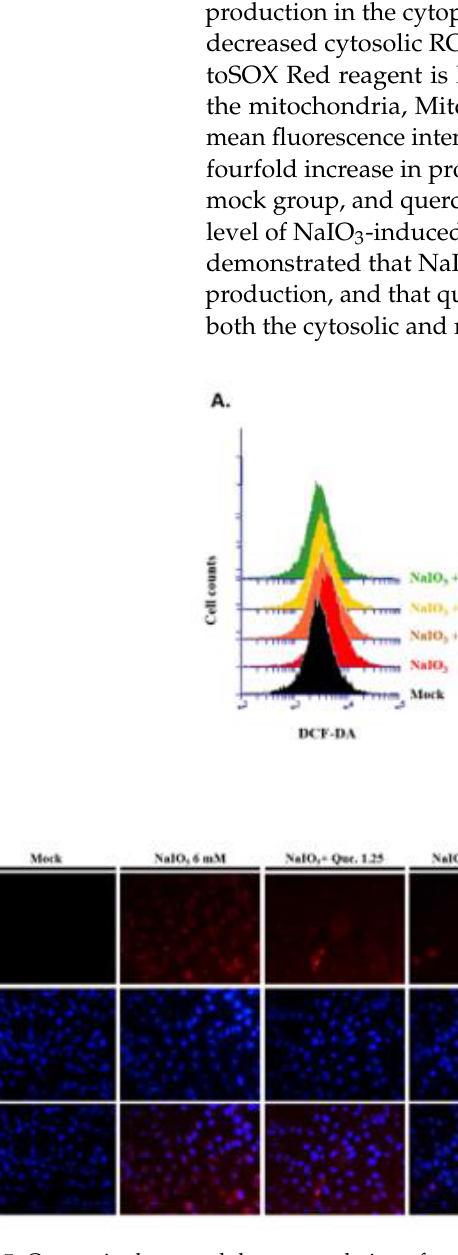
Figure 5. Quercetin decreased the accumulation of cytosolic and mitochondrial ROS in NaIO 3 -treated ARPE19 cells. ARPE- 19 cells were either untreated (mock) or treated with 0, 1.25, 2.5, or 5 μM quercetin followed by NaIO 3 (6 mM). ( A ) After incubation with H2DCF-DA, the results are expressed as the dot plots of DCF fluorescence per group in flow cytometry. ( C ) After incubation with MitoSOX™, the intensity of mitochondrial ROS in each group was measured using inverted fluorescence microscopic images. ( B , D ) The quantified analysis is shown as mean ± SD ( n = 3, 3 individual set experiments with at least two duplicates per set of groups). The letters a, b, and c indicate statistically a significant difference ( p < 0.05).